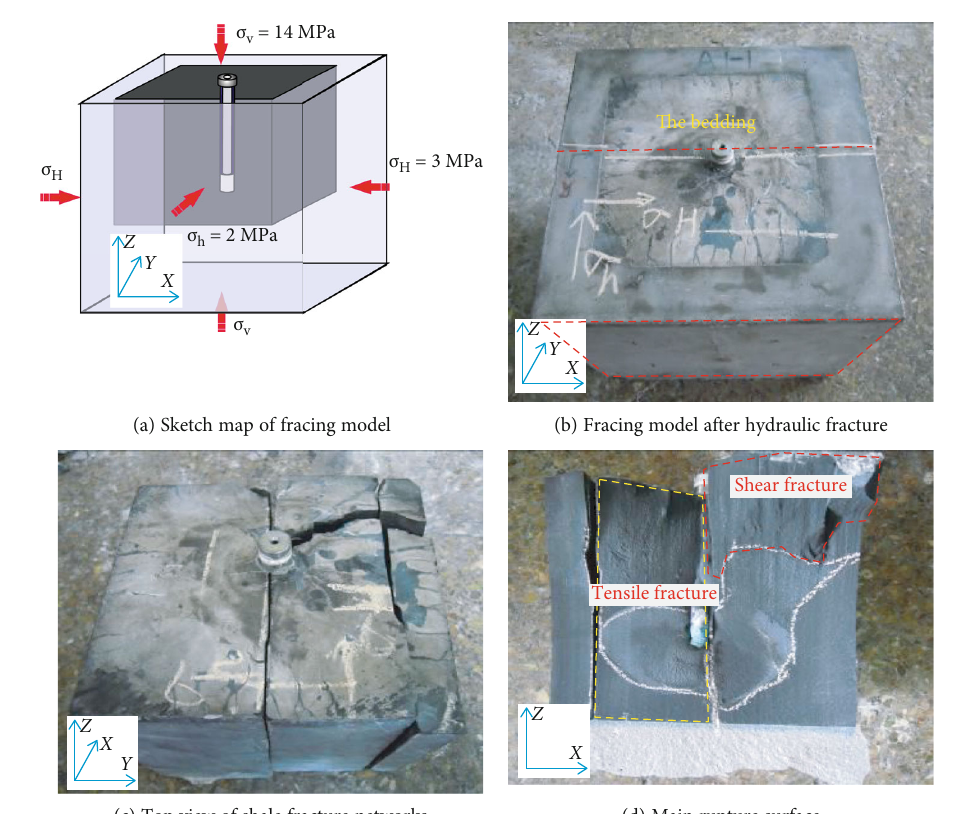
Figure 9: Failure patterns of specimen